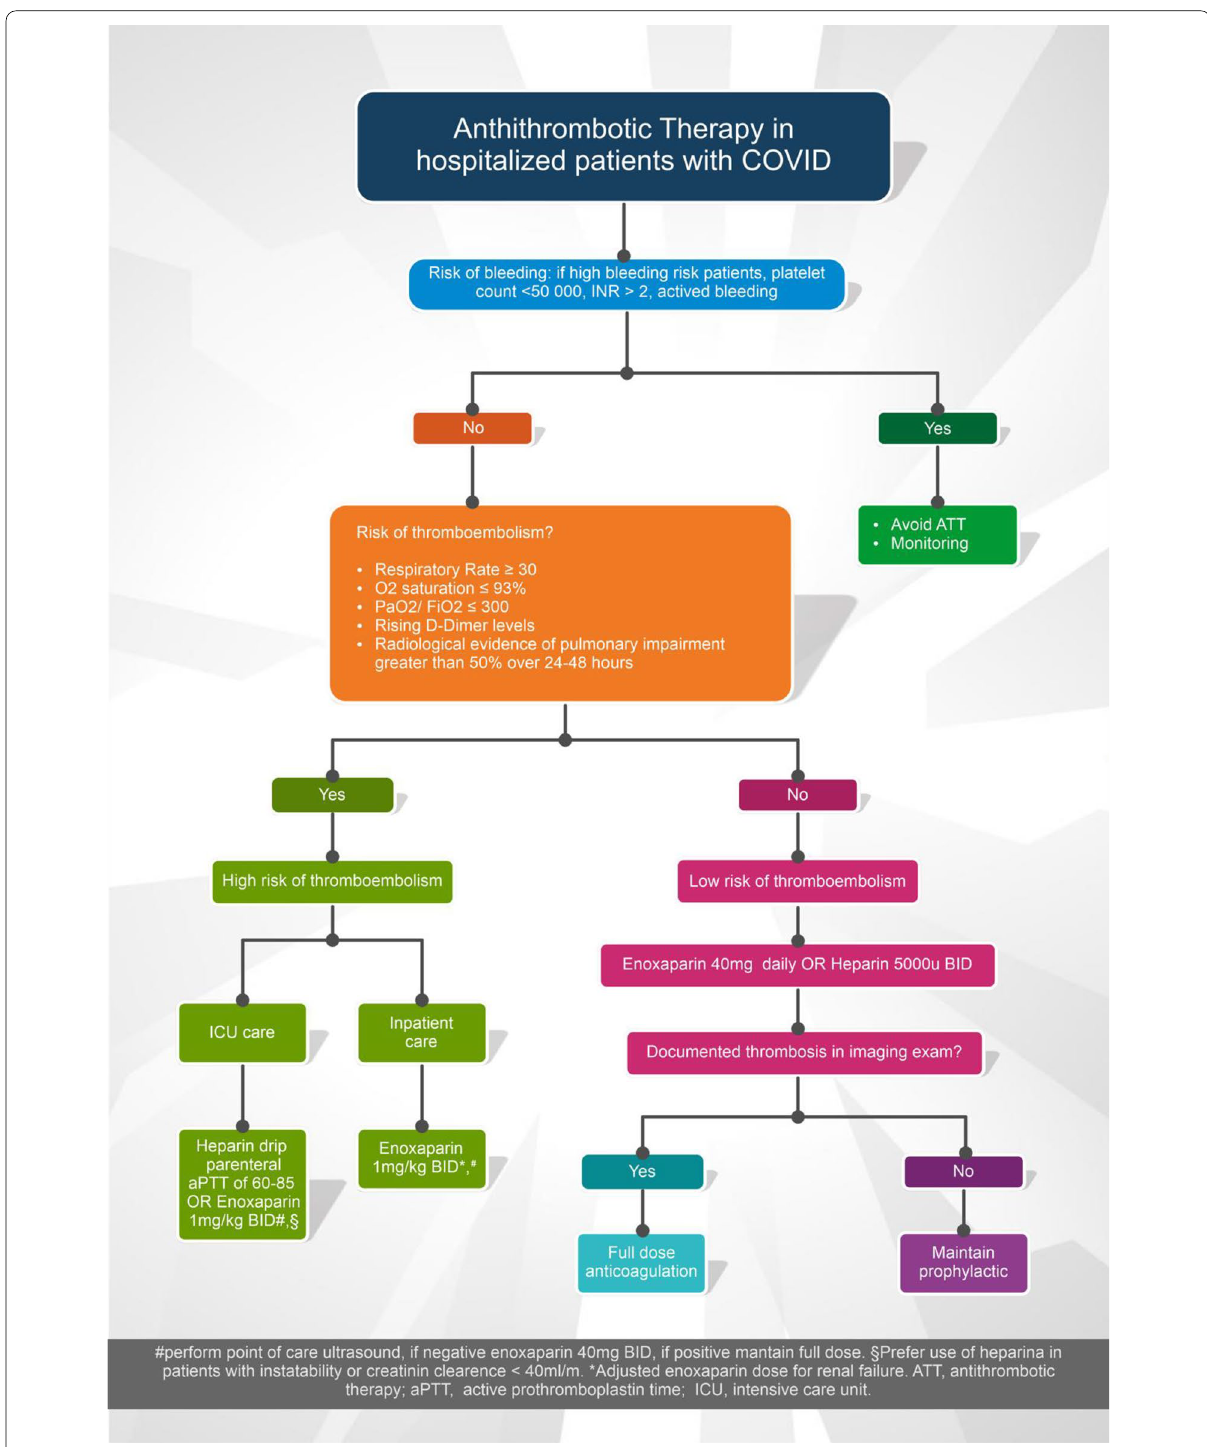
Fig. 4 Algorithm proposed for the management of antithrombotic therapy in patients with